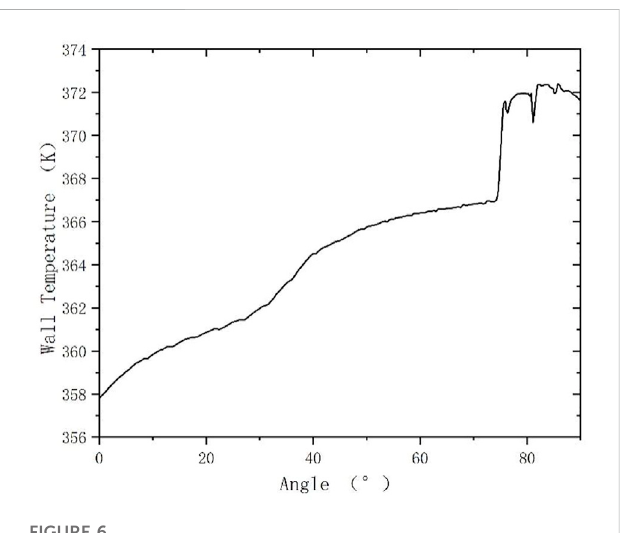
FIGURE 6 Variation curve of the void fraction on the heating wall with angle.